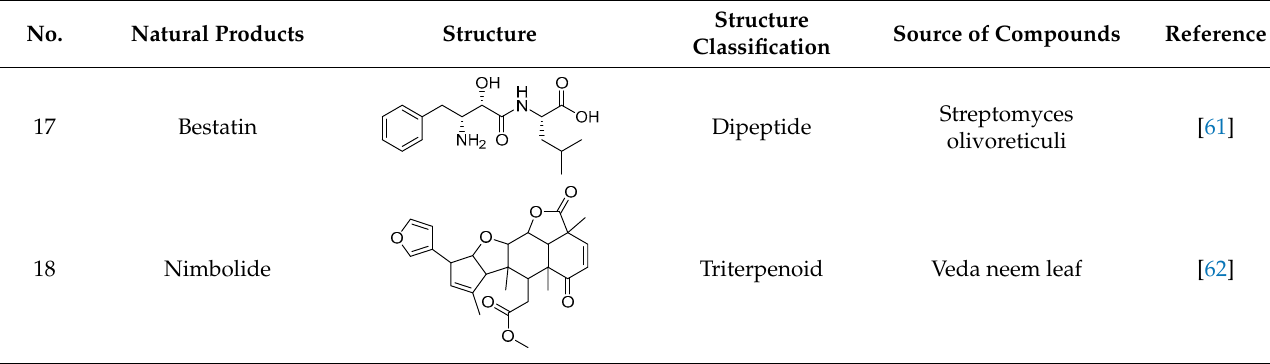
Table 9. Natural products 17–18.